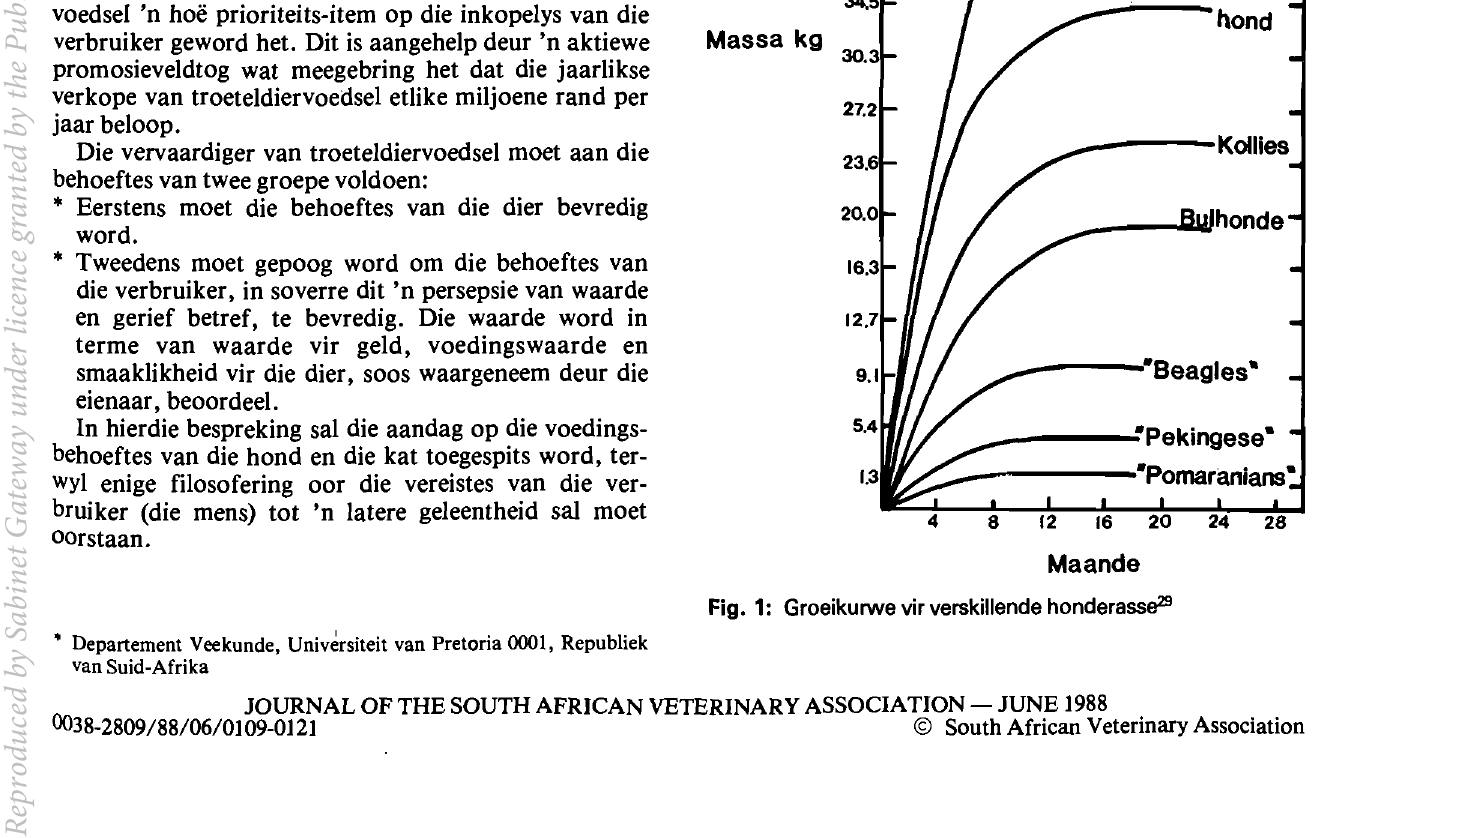
Fig. 1: Groeikurwe vir verskillende